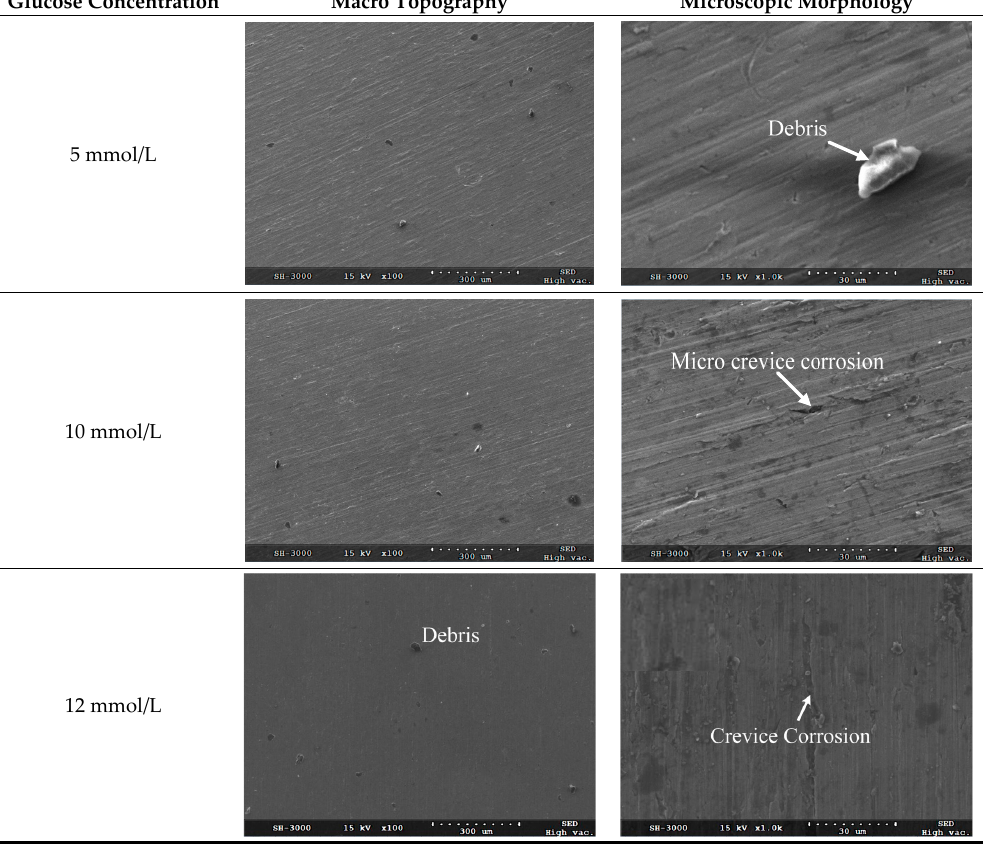
Figure 5. Cont. Figure 5.